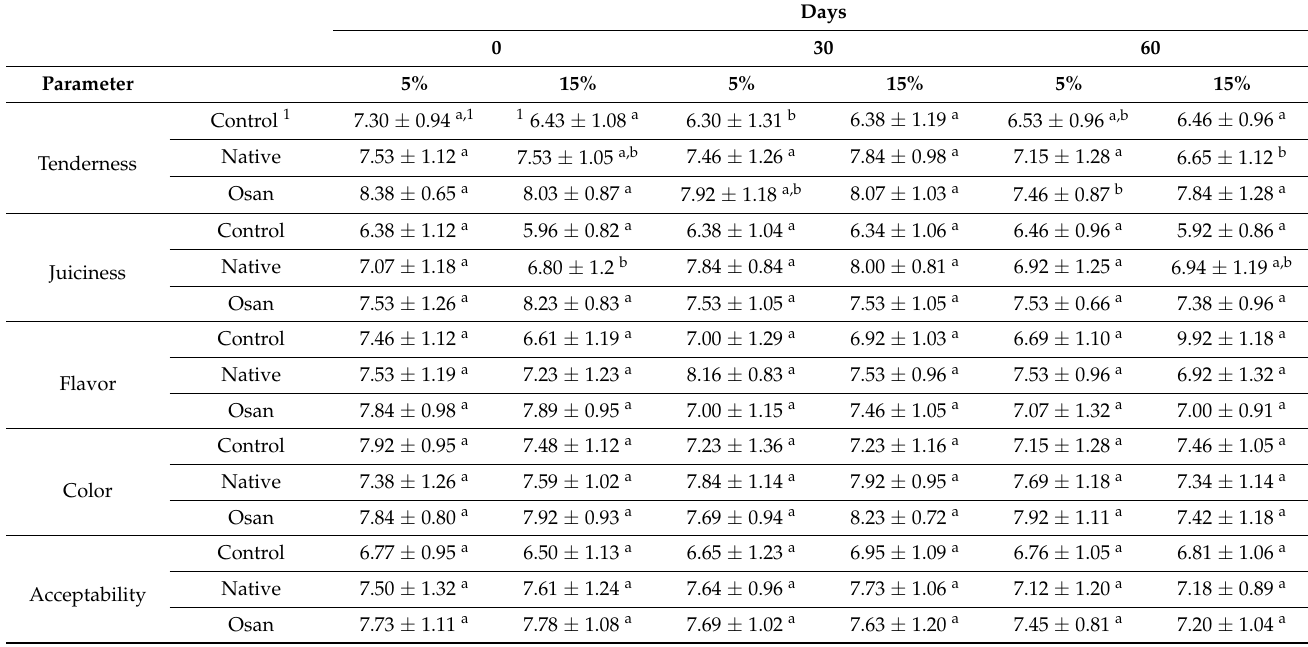
Table 5. Effects of different levels of octenyl succinylated (Osan) corn starch, native starch, and animal fat on the sensory characteristics of meat patties after storage at − 20 for different